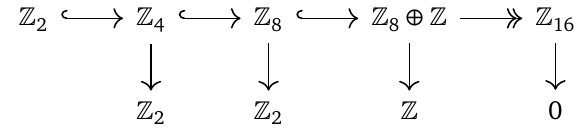
Figure 3: The injectivity proof for the Smith isomorphism theorem in a nutshell: one uses a nullbordism Z of the image of the Smith map ( X , A ) (cid:55)→ ( Y , A | a bordism ( W , ˜ A ) , depicted above, of ( X , A ) to ( X (cid:48) ,0 ) (blue), with the latter carrying no (cid:90) bundle. Indeed the green curve Poincaré dual to ˜ A only meets the boundary of 2 the bordism along X